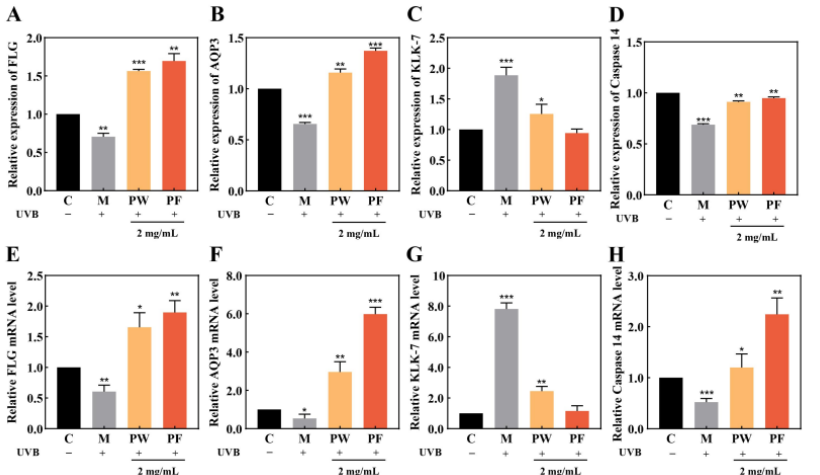
Figure 7. Effects of 2 mg/mL PF on activity and mRNA expression of skin barrier-related factors in HaCaT cells. ( A , E ) FLG protein activity and mRNA expression level; ( B , F ) AQP3 protein activity and mRNA expression level; ( C , G ) KLK-7 enzyme activity and mRNA expression level; ( D , H ) Caspase 14 enzyme activity and mRNA expression level. PW: Passiflora edulis Sims peel water ex- tract. PF: Passiflora edulis Sims peel fermentation broth. C: control group. M: UVB damage model group. Each value is expressed as mean ± SD ( n = 3). (*: p < 0.05, **: p < 0.01, ***: p < 0.001, versus PW group).